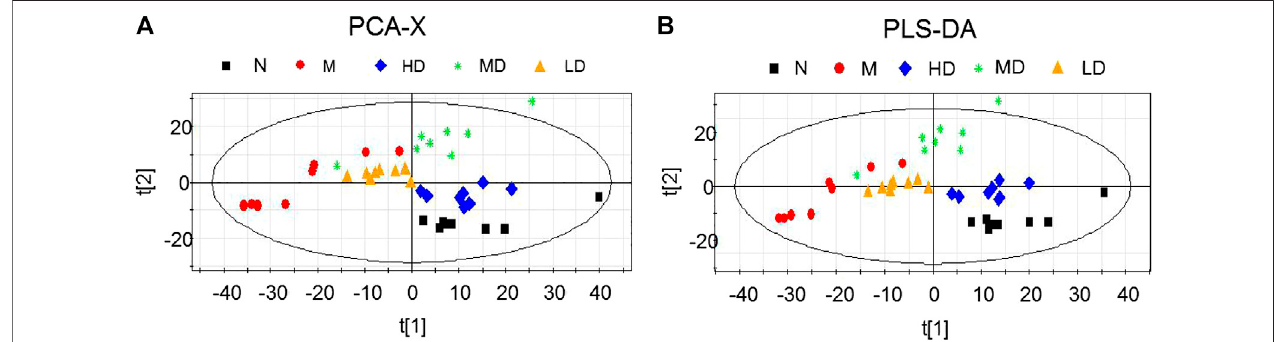
FIGURE 4 | Scores plots of multivariate statistical analysis on urine samples. (A) Principal Component Analysis (PCA) scores plot; (B) Partial Least Squares- discriminant Analysis (PLS-DA) scores plot.